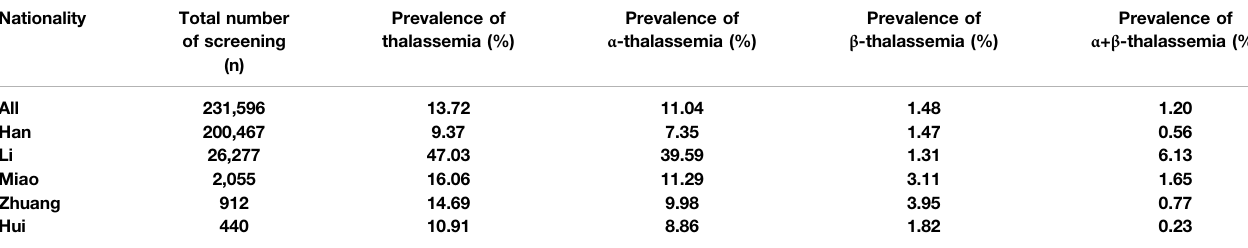
Prevalence of β -thalassemia (%)